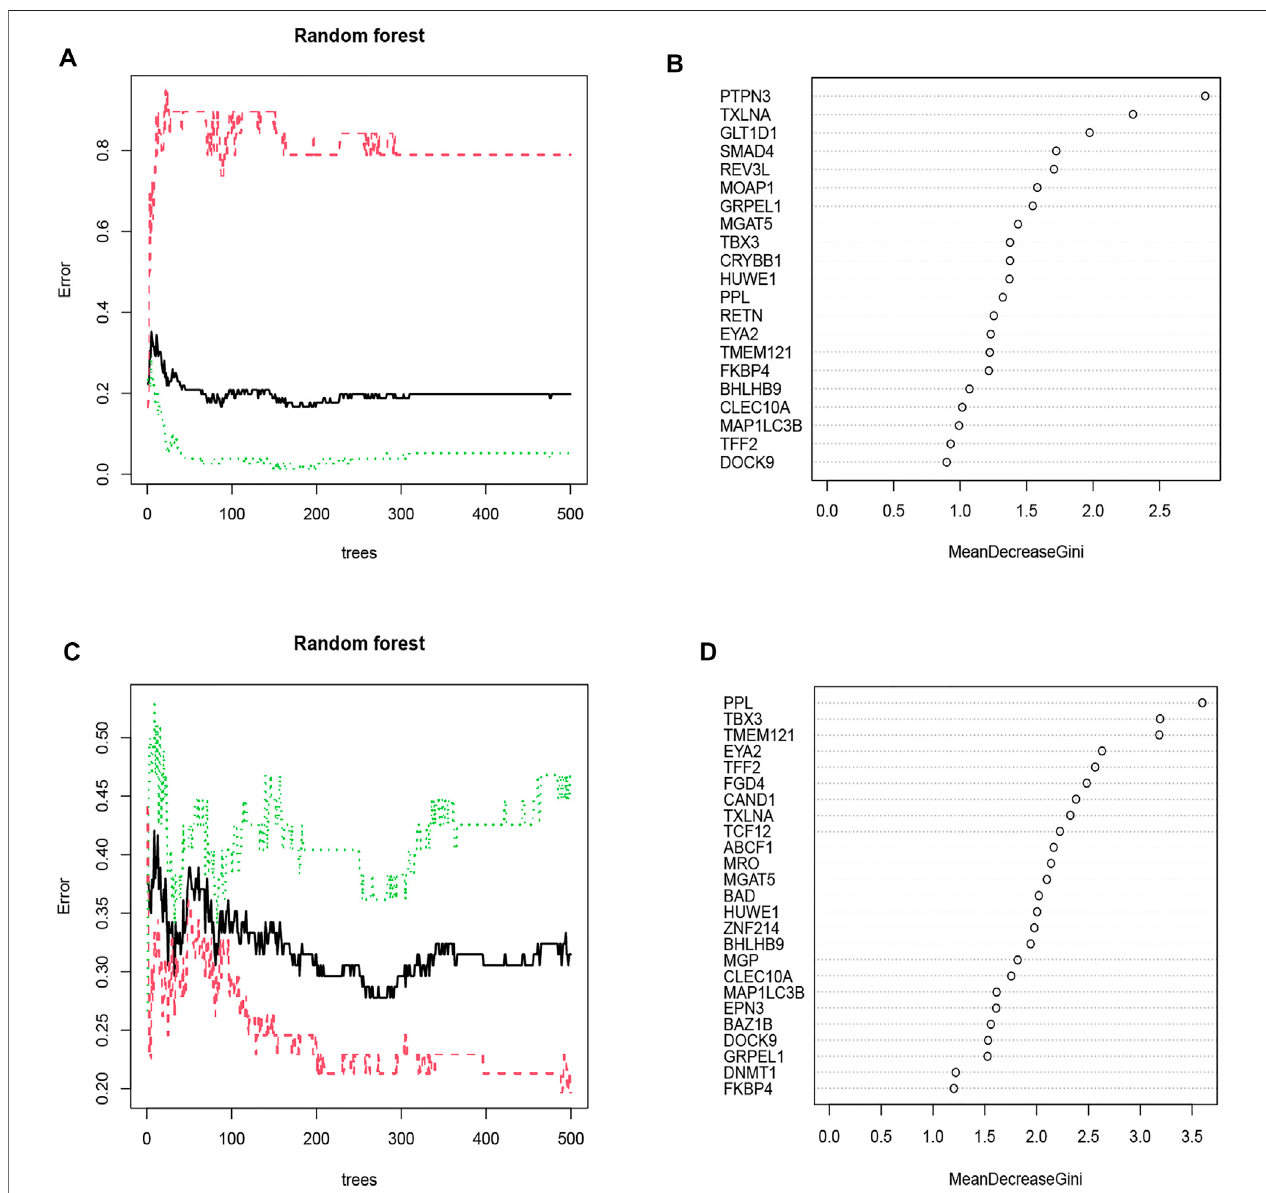
FIGURE4|(A) Theimpactofdecisiontreenumberonerrorrate.Thedecisiontreewasplottedalongthex-axisandanerrorratealongthey-axis.TheOSAcohort ’ s error rate was relatively low when approximately 87 decision trees were plotted. (B) The Gini coef fi cient method in random forest modeling of the OSA cohort. Genetic variables are plotted on the y-axis, and importance indexes on the x-axis. (C) The CPAP cohort ’ s error rate was relatively low when approximately 258 decision trees wereplotted. (D) TheGinicoef fi cientmethodinrandomforestmodelingoftheCPAPcohort.Geneticvariablesareplottedonthey-axis,andimportanceindexeson the